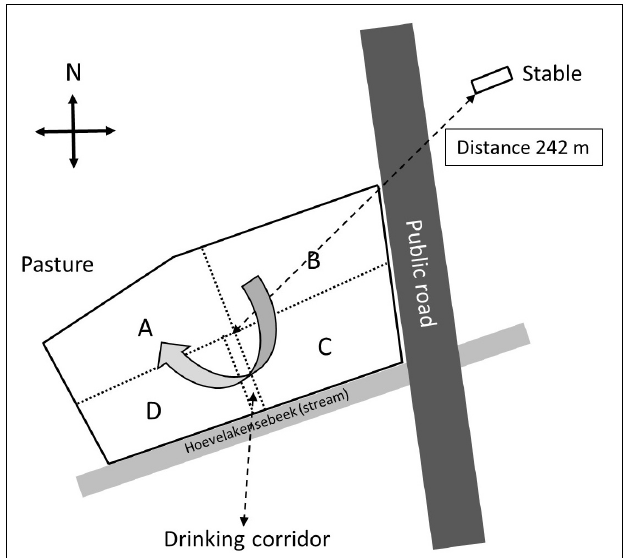
FIGURE 1 | Schematic overview of the surveyed farm near Nijkerk including the stable with 50 calves and the pasture land with 15 heifers (grazing heifers were only present in 2014). The pasture was separated by electric wiring into four sectors (A through D) and a drinking corridor to allow the heifers to drink from a water reservoir near the stream. The heifers were weekly, clockwise, rotated to another sector with freshly grown grass, and at the moment of the first sampling (August 2014), the heifers were located in sector